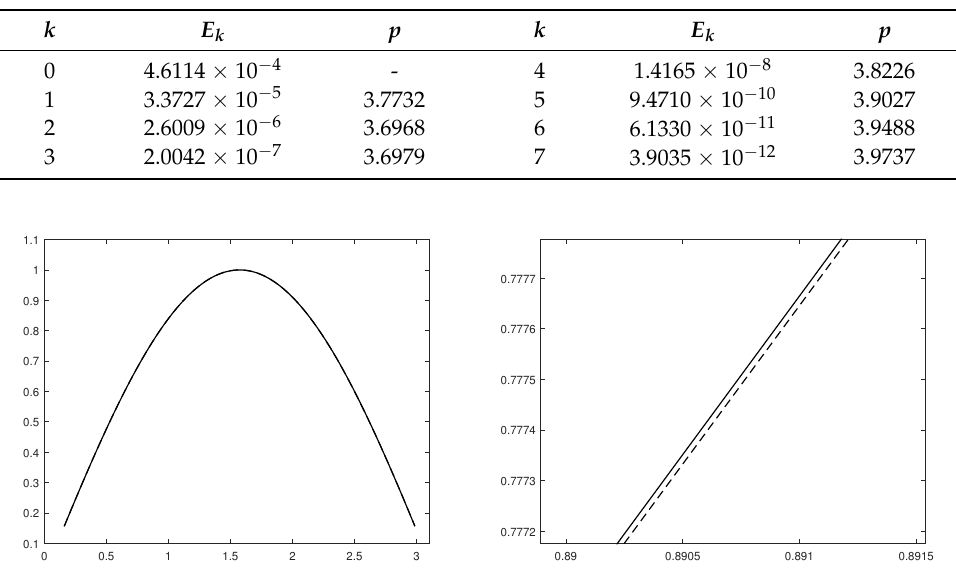
Table 1. Approximation errors E k in the l ∞ norm and corresponding approximation orders p obtained after k iterations for the PPH reconstruction with f ( x ) = sin ( x ) , k = 0,1,...,7.